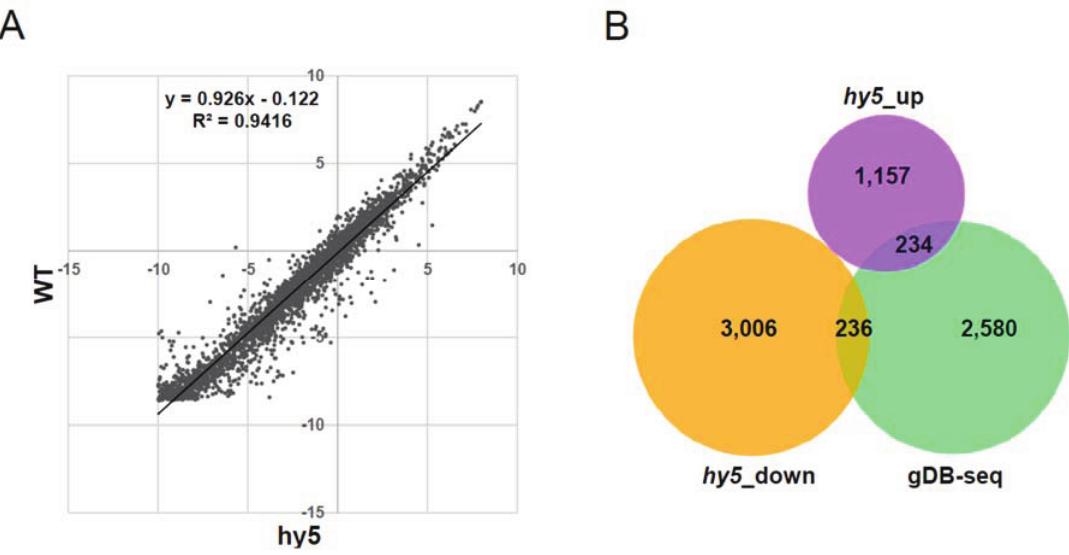
Figure 7. Microarray analysis in hy5 null mutant. ( A ) Dot plot of the accumulation of 3050 HY5-binding genes in wild type (WT) and hy5 . LOG2 values of normalized signals were plotted. ( B ) Venn diagram of overlaps between HY5-binding genes and genes that showed a significant difference in microarray analysis in the hy5